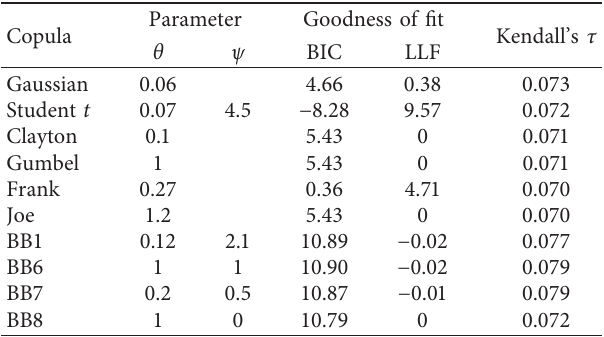
Table 10: Estimated copulas’ parameter estimates and goodness- of-fit criteria